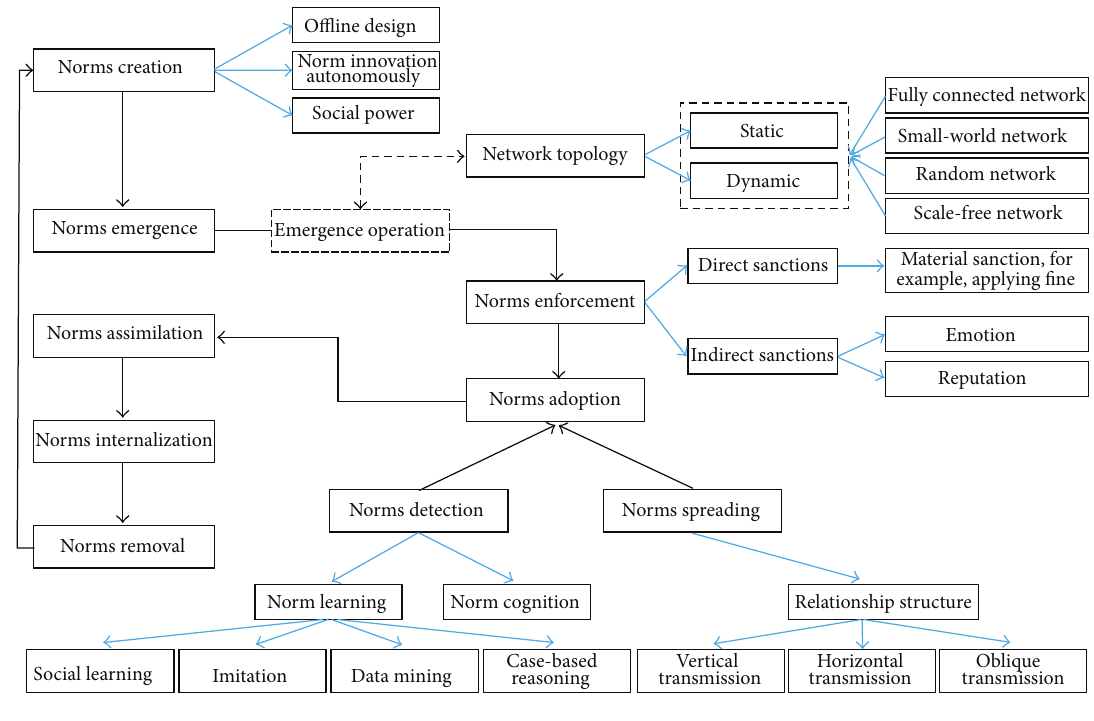
Figure 15: The proposed model with